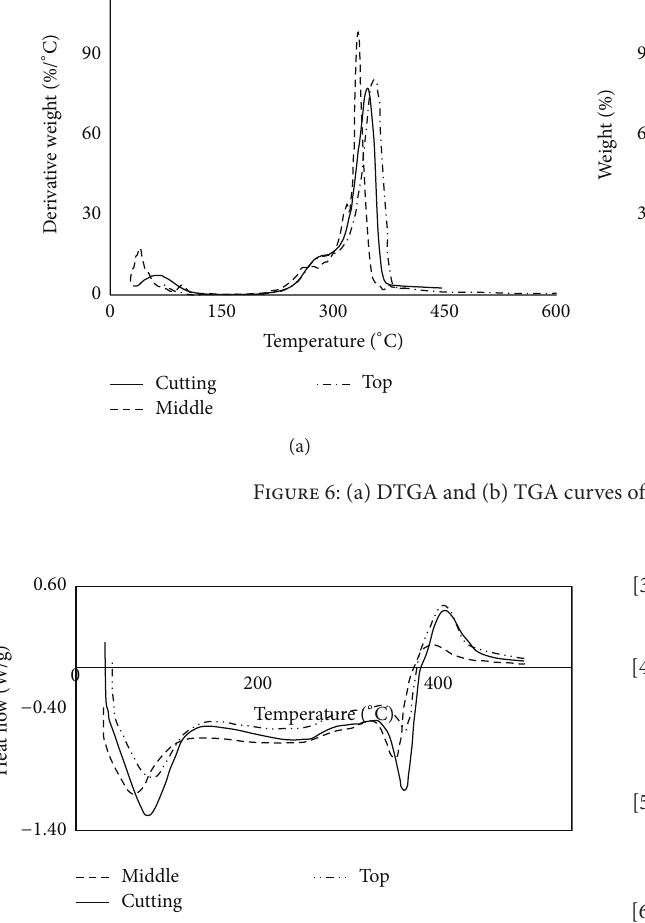
Figure 7: DSC curves of three portions of raw jute fibers.